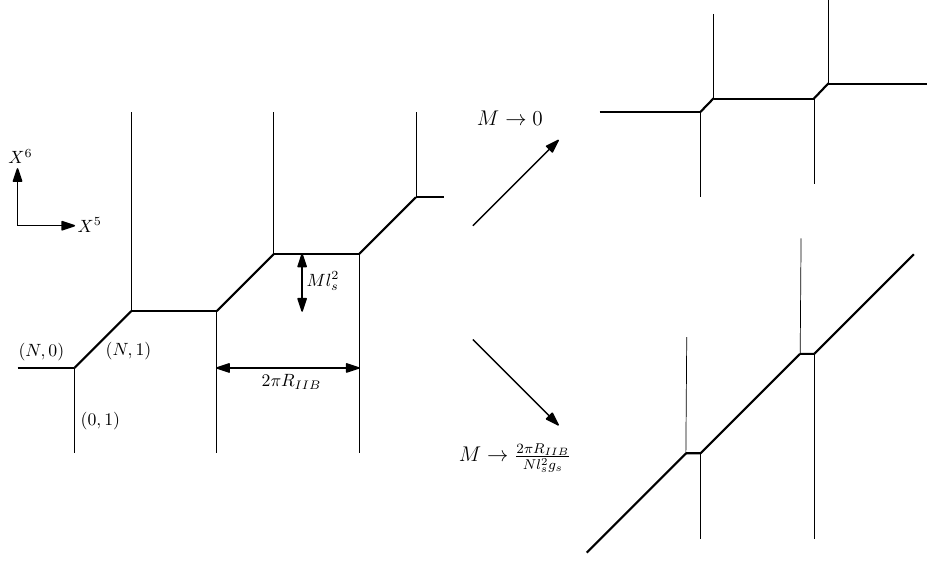
Figure 1 . Type IIB 5-brane web for the 5d N = 1 (cid:3)